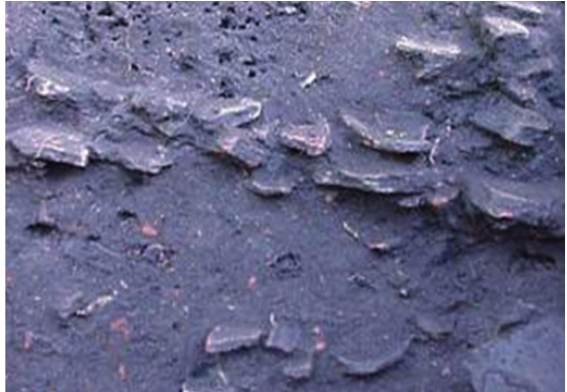
Figure 3 - Nutrient-enriched terra preta soil, rich in black carbon (charcoal) and ceramic fragments, resulting from long- term human occupation, beneath a forest in Brazil. Photo courtesy of Bruno glaser, University of Halle-Wittenberg, Halle,